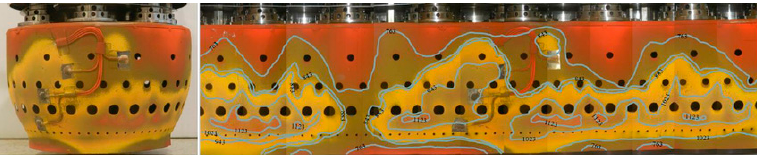
Figure 22. Thermal paint gradients of the combustor outer liner [199], with permission from Begell House, Inc.